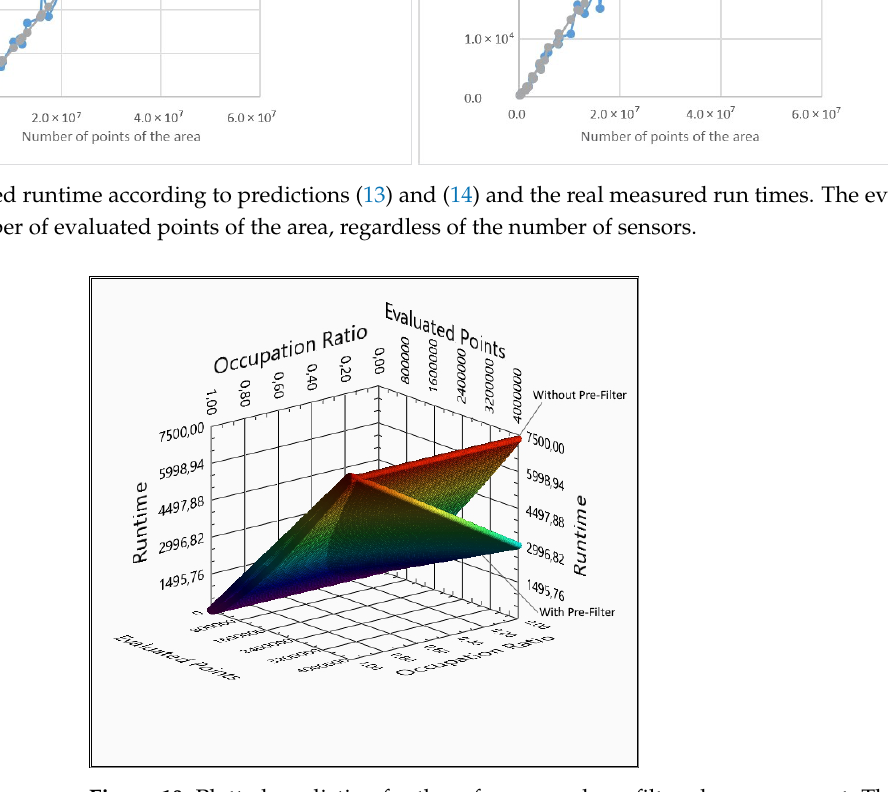
Figure 10. Plotted prediction for the reference and pre-filtered measurement. The plane represents the measurement without pre-filtering, and the curved surface belongs to the pre-filtered prediction, the intersection shows where the pre-filtering has no advantage to the reference measurement. The X axis represents the occupation ratio, the Y axis is the number of evaluated points and the Z axis is the